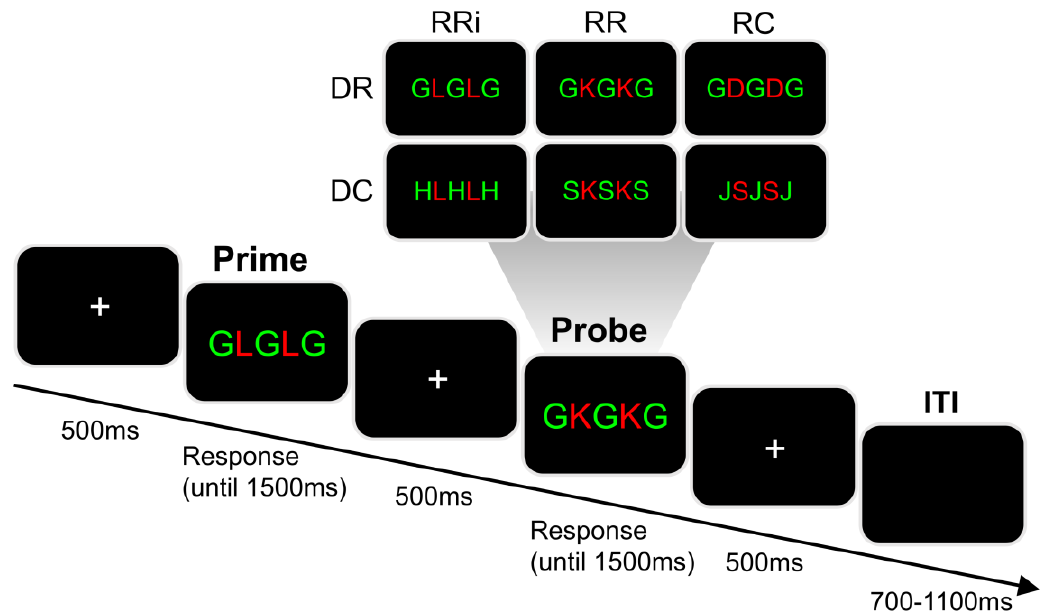
Figure 3. Illustration of the time course in milliseconds (ms) of a single trial in the distractor-response paradigm [29]. In each trial, a white fixation cross was centrally shown on a black screen for 500 ms. This was followed by a centrally presented prime array consisting of five letters. The prime array presentation was terminated either by a button press in response to the red target letters, or after 1500 ms (in case of a missing response). After another presentation of a central white fixation cross for 500 ms, a probe array was centrally presented. The probe array also consisted of five letters and its presentation was again terminated by a button press in response to the red target letters or ended after 1500 ms. The inter-trial interval (ITI) was jittered between 700 and 1100 ms. The upper half of the figure illustrates exemplary probe arrays for each combination of conditions in relation to the prime array used for illustration in this figure (“G L G L G”). Depending on whether the target and / or distractor stimulus were repeated or changed between prime and probe array, six di ff erent combinations of conditions were distinguished. In terms of the distractor stimuli, distractor repetition (DR) and distractor change (DC) were distinguished. In terms of the required response, response repetition when the target stimulus was identical (RRi), response repetition when the target stimulus di ff ered (RR), and response change (RC) were